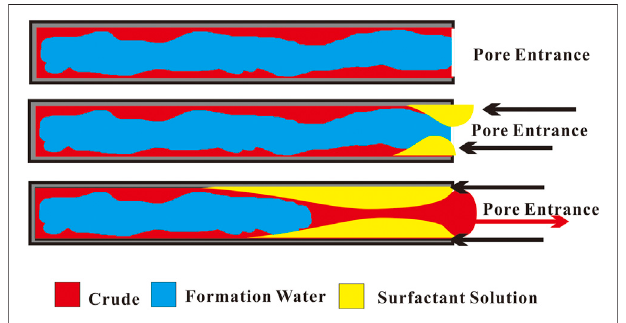
FIGURE 1 | The hypothetical mechanism imbibition process.